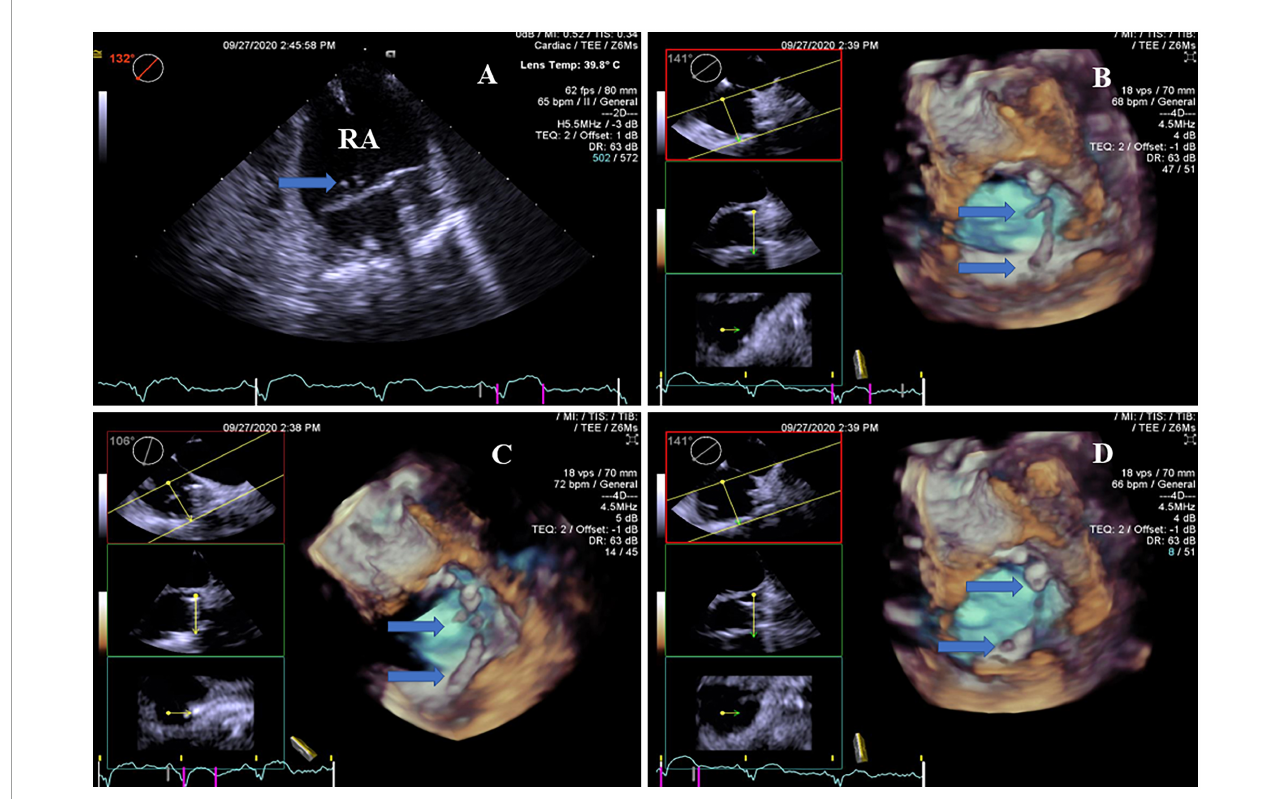
FIGURE3 Real-time four-dimensional-TEE evaluating the pacemaker lead-related thrombus, as compared with 2D-TEE. (A) 2D-TEE showed two clots stuck to the lead of the pacemaker in the right atrium (arrow). Note severe spontaneous echo contrast throughout the right atrium. (B) RT4D-TEE demonstrated more clots attached to the lead of the pacemaker in the right atrium and more clearly than 2D-TEE (arrow). (C) RT4D-TEE showed more scatter clots on the lead of the pacemaker in the right atrium from a different angle (arrow). (D) RT4D-TEE revealed more lead-related thrombi throughout the lead of the pacemaker in the right